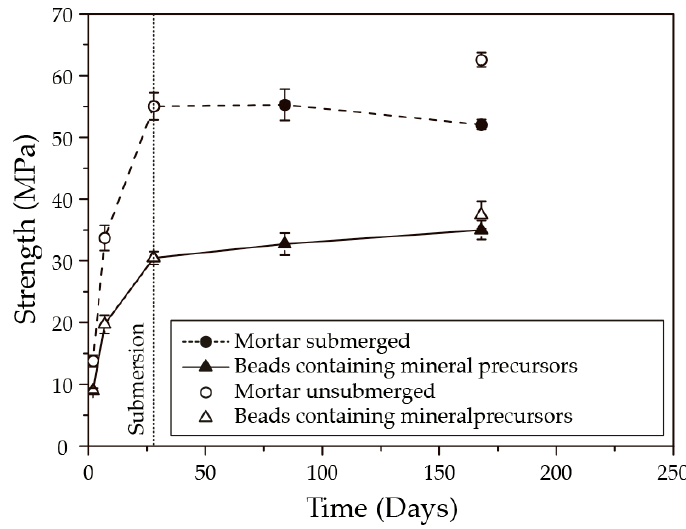
Figure 8. Compressive strength development of mortar cubes and mortar cubes incorporated with beads containing mineral precursor compounds, cured for 28 days and subsequently submerged in artificial seawater at 8 °C.